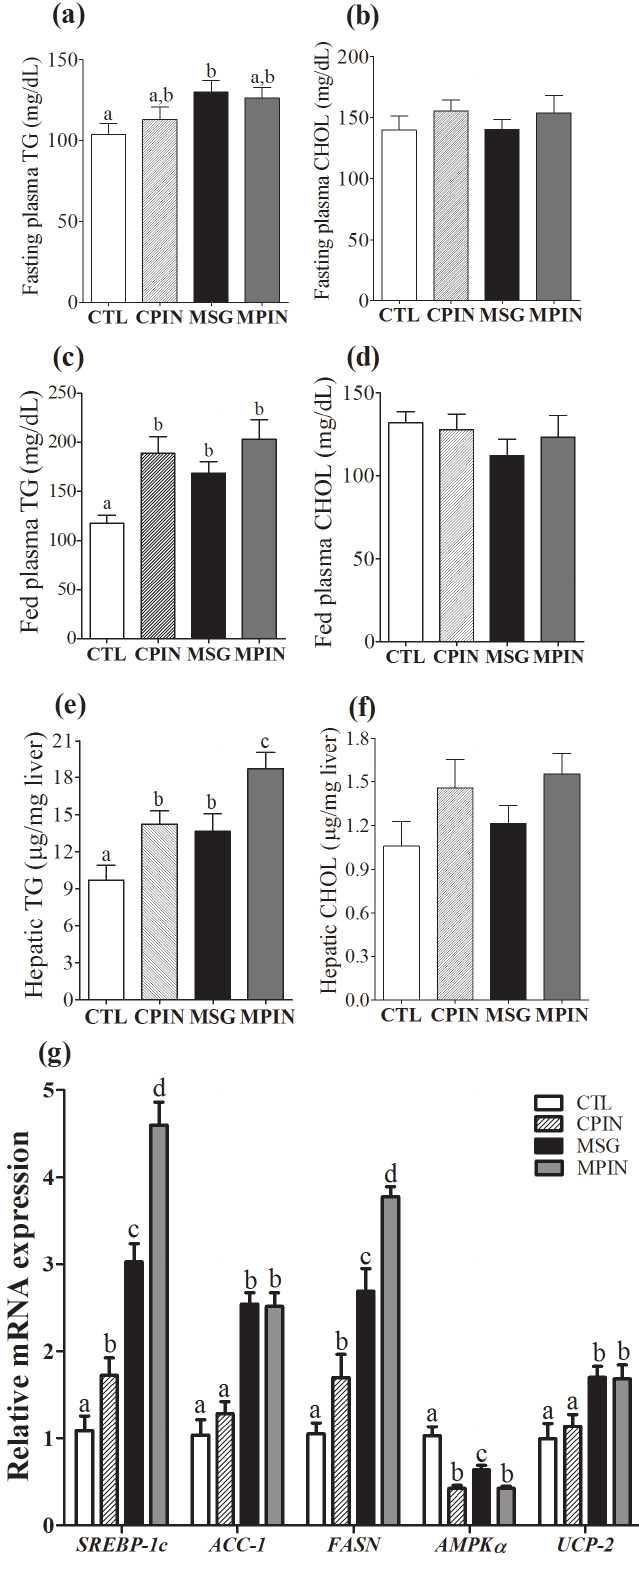
Figure 2. D-pinitol did not change circulating lipids in MSG-obese mice, but increased TG content in the liver of these rodents and also in CPIN mice, through regulation of genes involved in hepatic lipid metabolism. Means ± SEM of plasma TG (a and c) and total CHOL (b and d) plasma concentrations, and hepatic TG (e) and CHOL (f) contents of CTL (n = 15), CPIN (n = 15), MSG (n = 15) and MPIN (n = 12) mice. (g) Relative mRNA expressions of genes encoding SREBP-1c, ACC-1, FASN, UCP-2 and AMPKα in the liver of CTL (n = 7), CPIN (n = 7), MSG (n = 7) and MPIN (n = 7) mice. Different letters over the bars indicate significant difference (Kruskal-Wallis followed by Dunn’s post-test, P <